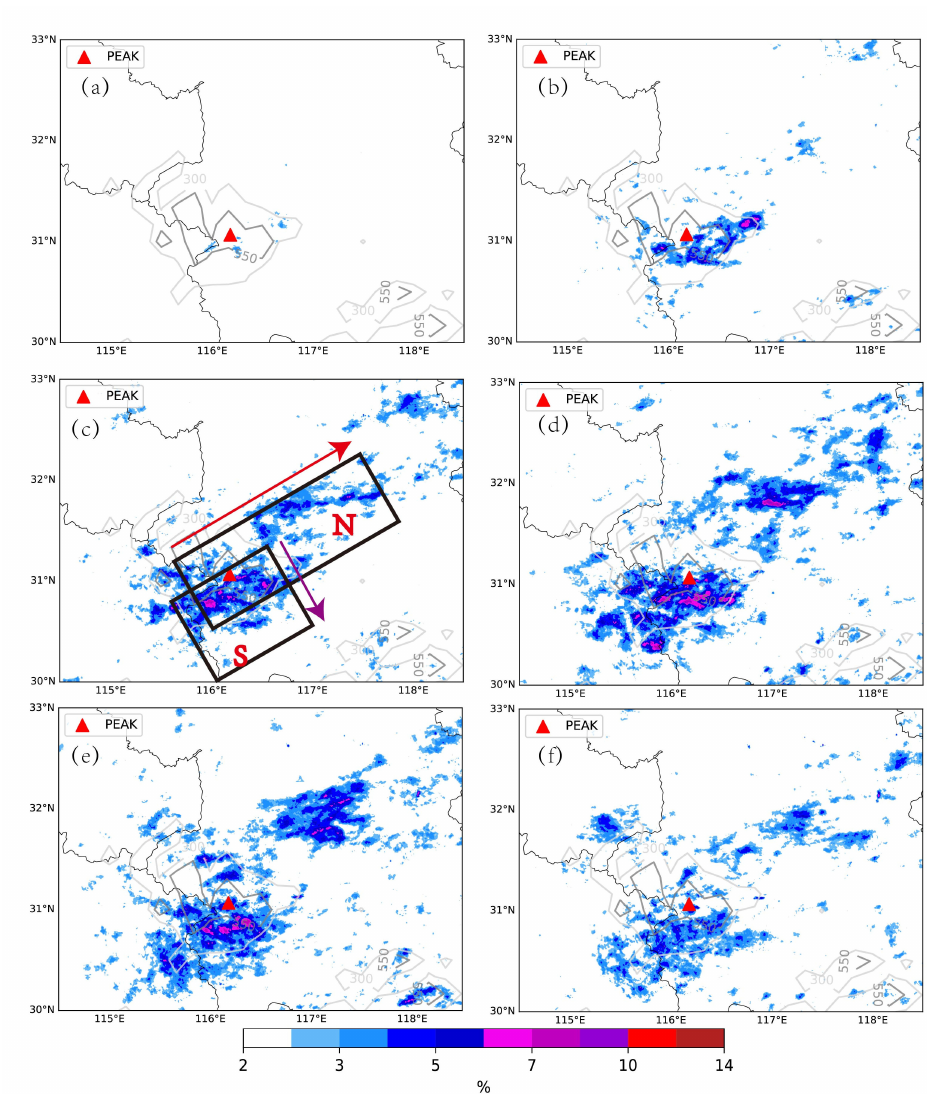
Figure 5. Frequencies of occurrence (%) for reflectivity > 40 dBZ at ( a ) 12:00, ( b ) 13:00, ( c ) 14:00, ( d ) 15:00, ( e ) 16:00, and ( f ) 17:00 BST. The two rectangle boxes in ( c ) indicate the subdomains for calculating the Hovmöller diagrams in Figure 6. The red arrow represents the x-axis direction of Figure 6a, and the purple arrow represents the x-axis direction of Figure